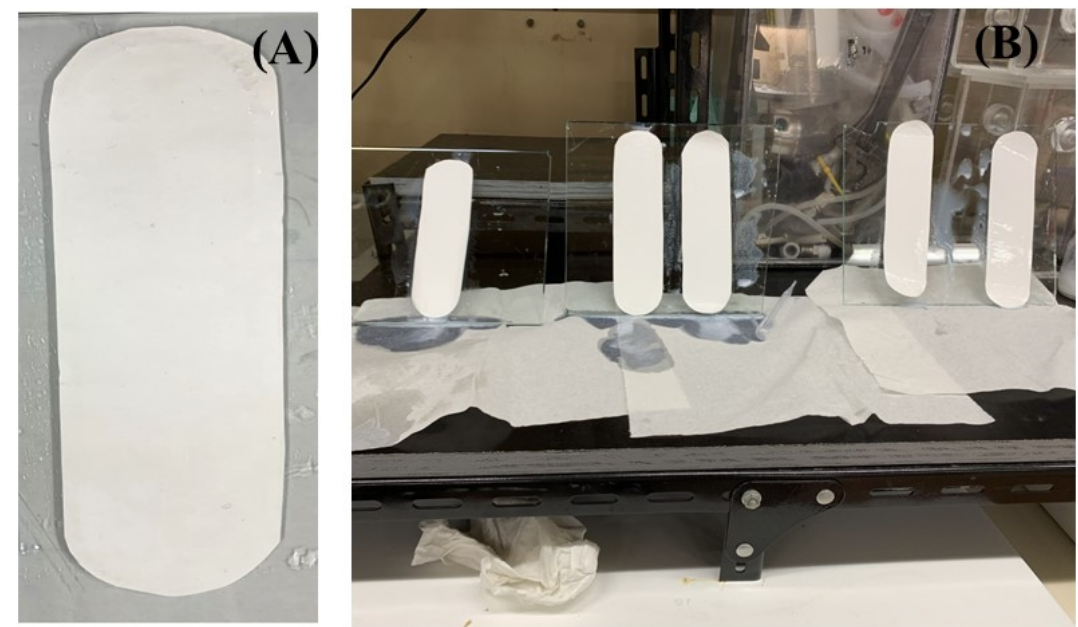
Figure A1. Actual images of the membrane ( A ) neat PVDF membrane ( B ) TiO 2 /PVA coated PVDF membrane with different TiO 2 loading (hang them for the removal of excess solution.